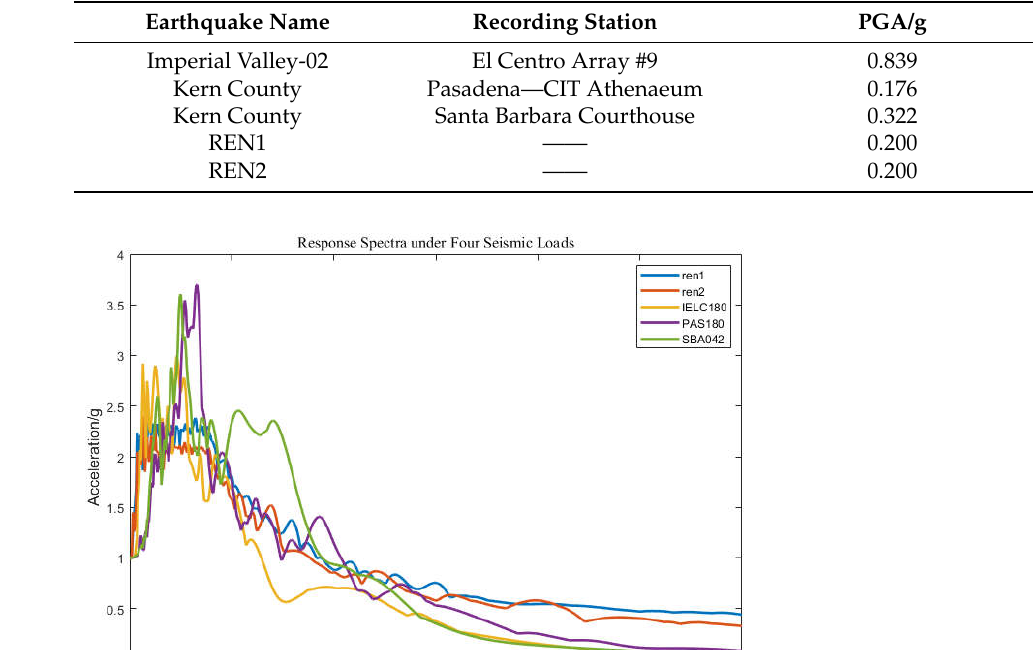
Table 2. Seismic-wave recording parameters.